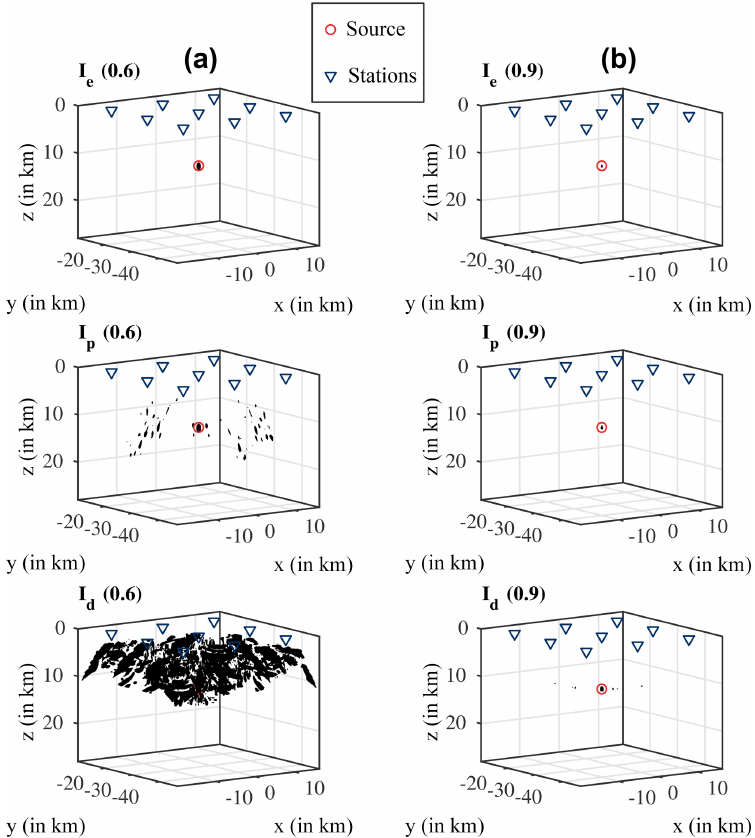
Figure 1. Imaging conditions plotted for one example simulation. Black spots are points with the values of 0.6 (in column a) and 0.9 (in column b) in the respective imaging conditions. I e would be classified into category I, I p would be classified into category II and I d would be classified as category IV, which would be regarded as unsuccessful. This example shows an explosion source at a depth of 11.9km with nine stations placed in a square. The inter-station distance is 13km. Only the part of the model underneath the stations is shown.